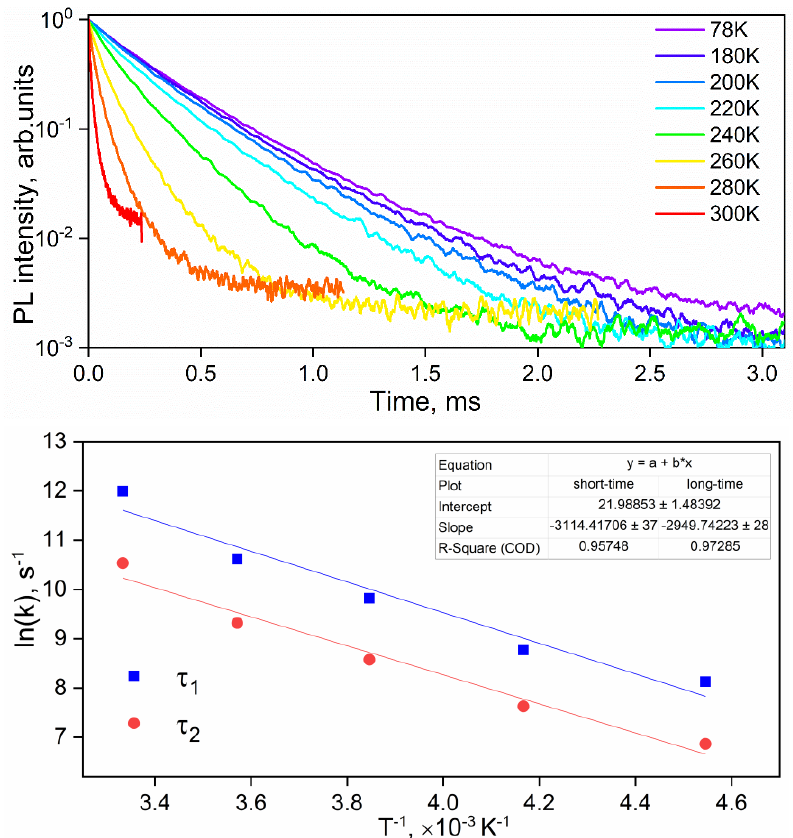
Figure 8. Temperature-dependent emission decays of complex 2p (top) in the solid state at temperatures of 78 – 300 K under pulsed laser excitation at 360 nm. Arrhenius analysis performed for the complex 2p (bottom).